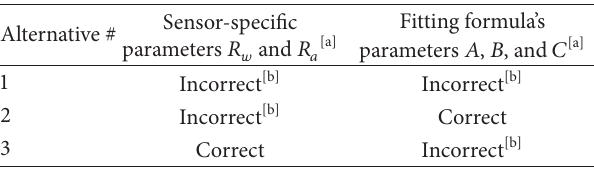
Table 2: Possible alternatives of incorrect readings.